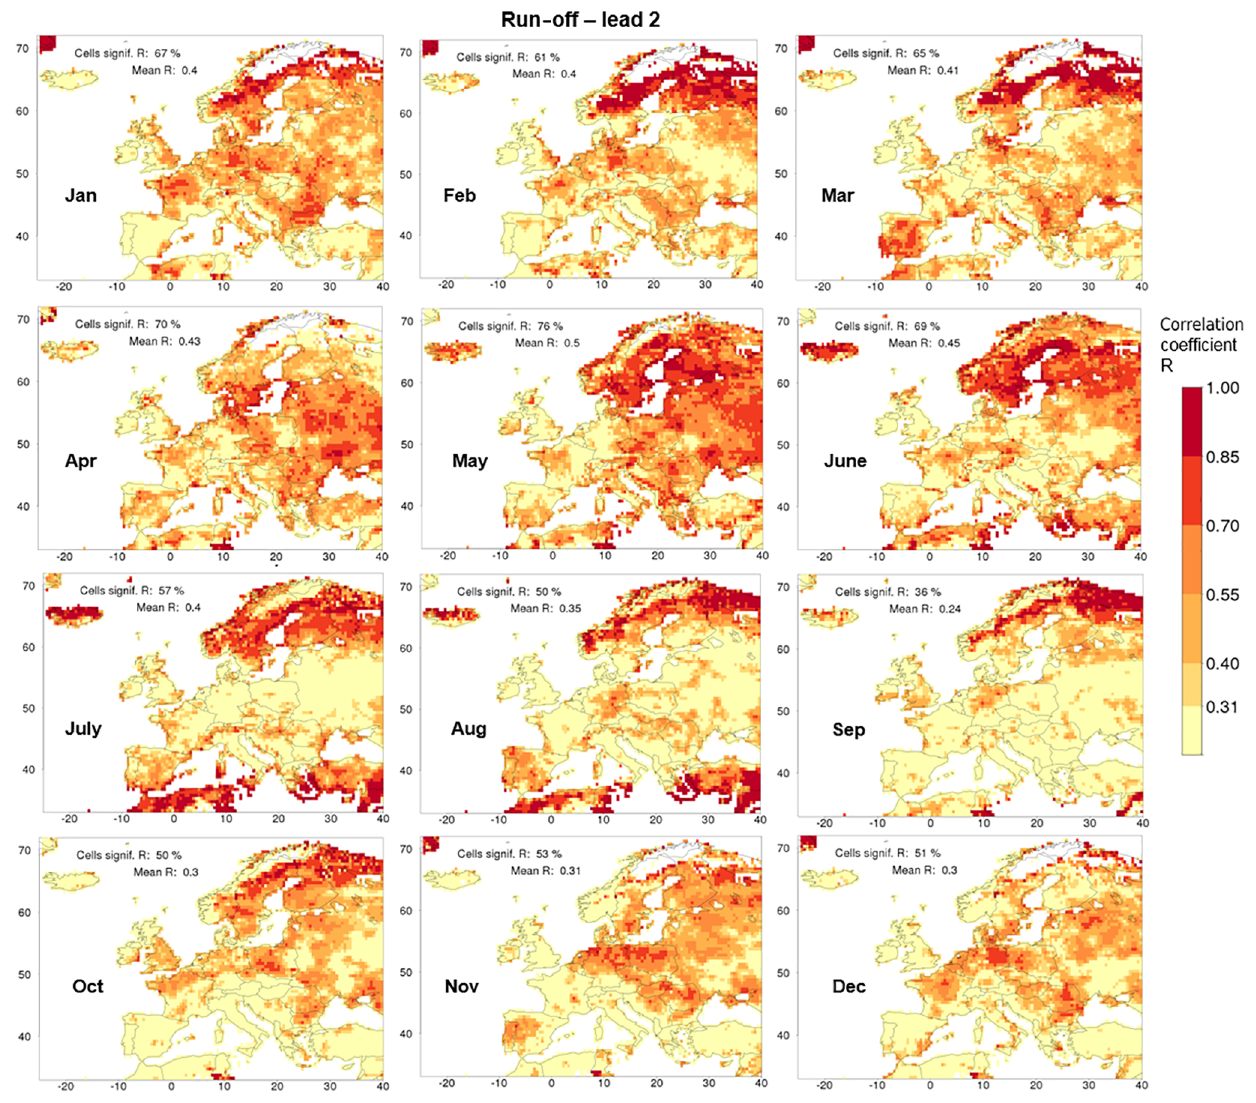
Figure 3. Annual cycle of skill ( R ) of run-off hindcasts for 12 target months, initialised at the beginning of the second month before (lead month 2). More explanation is given in the caption of Fig.